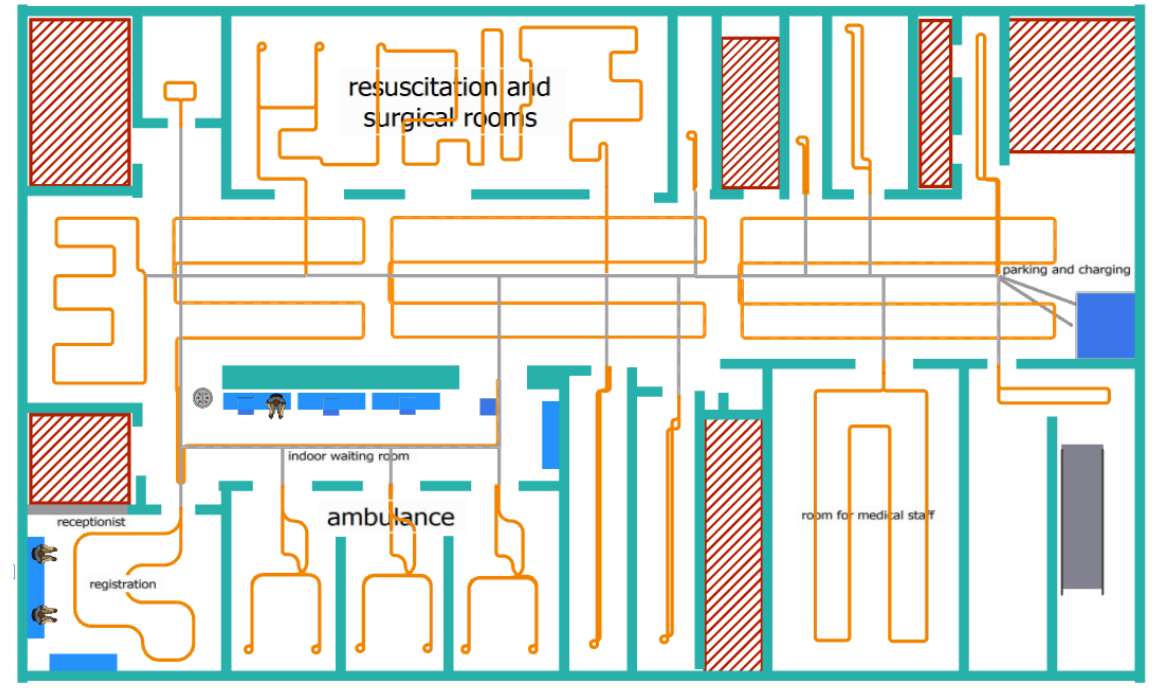
Figure 9. Created paths in the simulation model. The grey lines are marked access paths and the orange lines are individual disinfection paths.